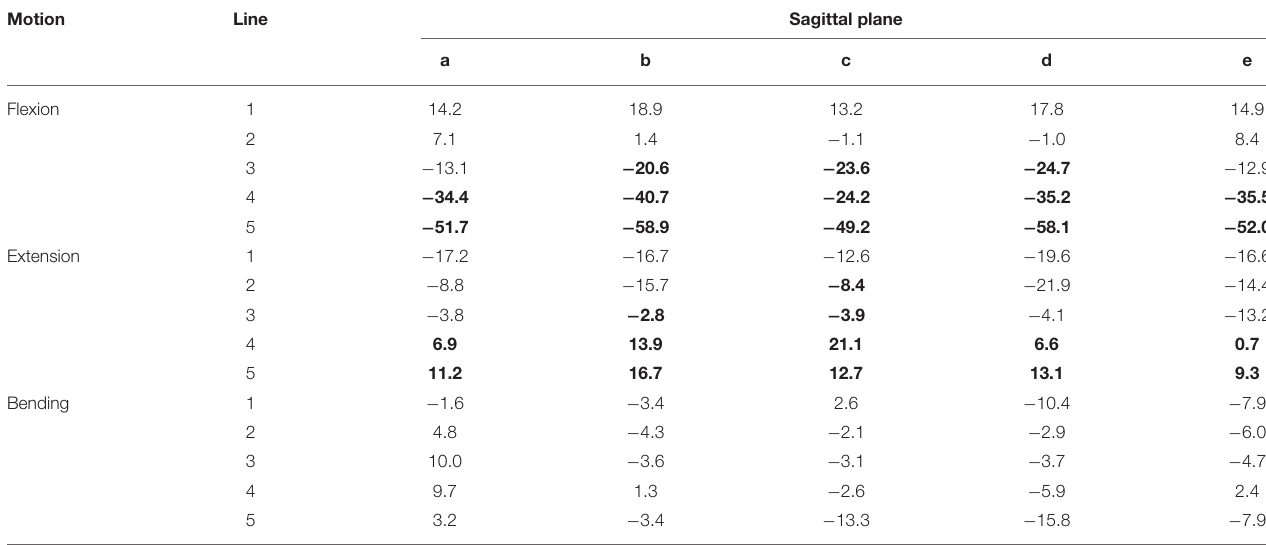
TABLE 6 | Changes in the IVD space averaged for the segments C4–C5, C5–C6, and C6–C7 width (%) in motion flexion, extension, and lateral bending compared with the neutral position in cats. Motion